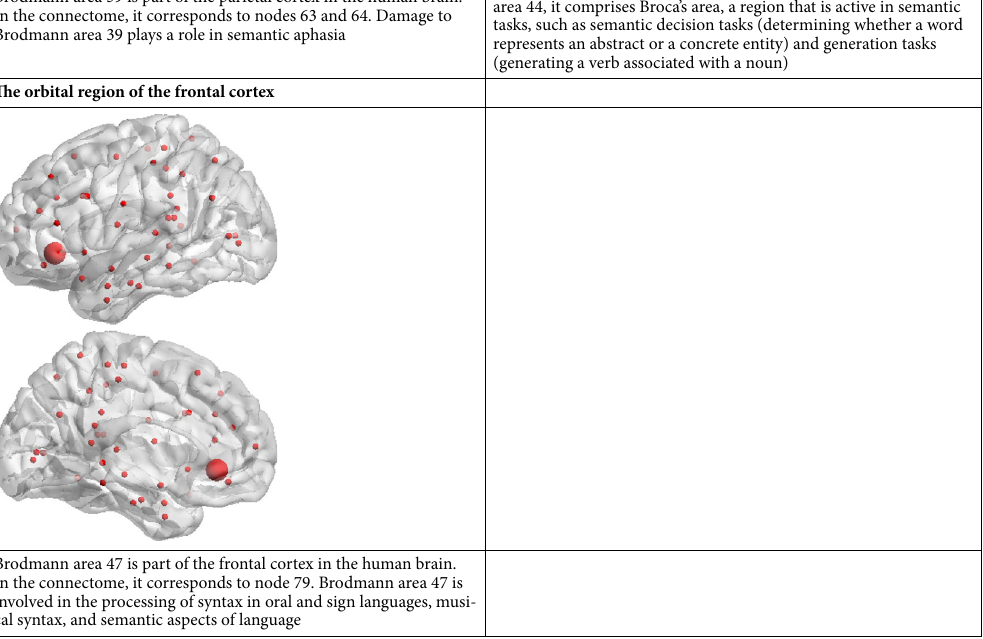
Table 2. Brodmann areas involved in the Action–Execution behavioral category. As we have already mentioned, such functional behavior can be accessed at the Brain Map web site (https:// portal. brain- map. org/) and visualized by the Mango software application (https:// ric. uthsc sa. edu/ mango/ mango.